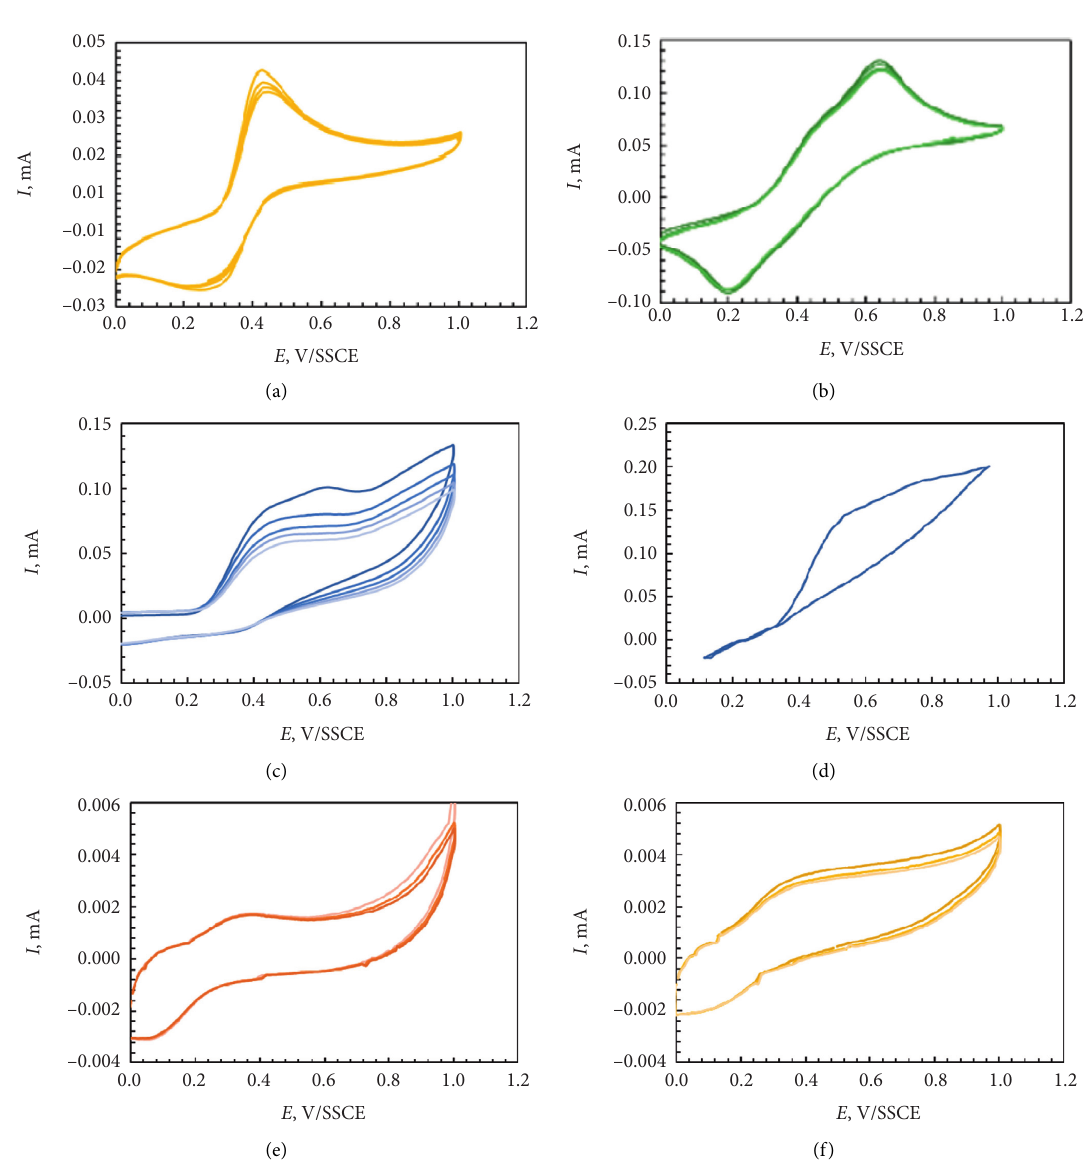
Figure 10: Cyclic voltammograms of 0.5mM/L caffeic acid (a); 0.5 mM/L chlorogenic acid (b); 0.5mM/L quercetin ( s ); 0.5mM/L gallic acid (d); 0.5mM/L(+)-catechin (e); and 0.5 mM/L ascorbic acid (f) at scan rate of 100 mVs − 1 in acetate buffer 0.1 M (pH 4) and NaClO 4 (70:28: 2). Scan rate – 100mVs − 1